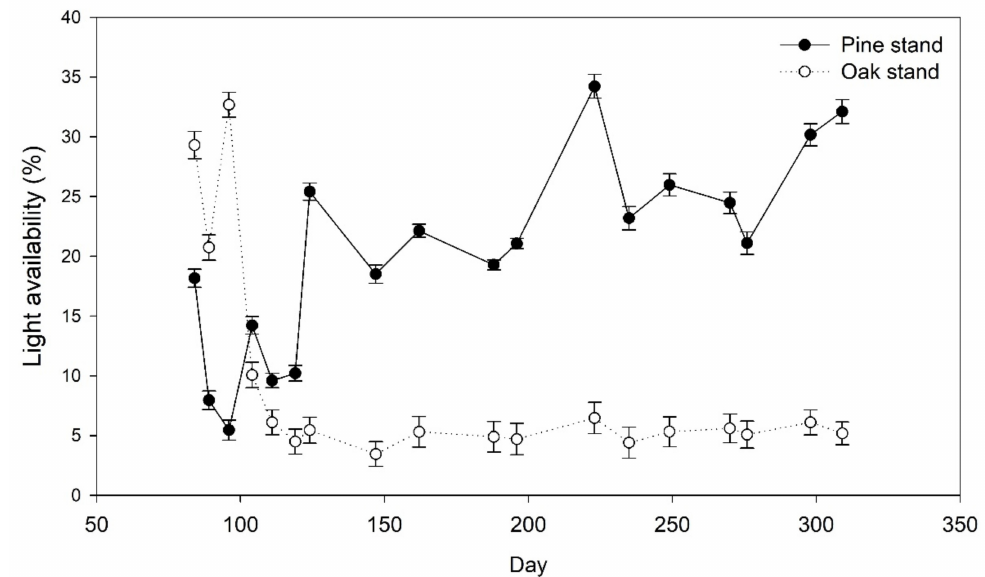
Figure 1. Light availability (%) at oak and pine stands measured during the onset of leaf flush until